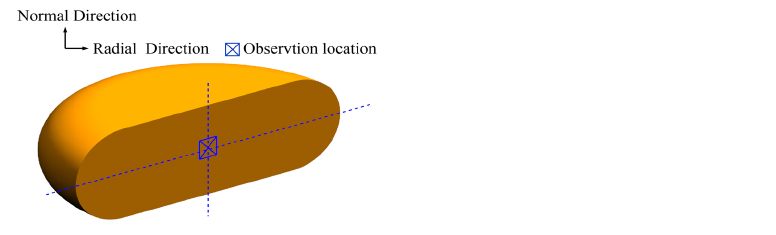
Figure 3. Schematic illustration of the section after an isothermal compression test.